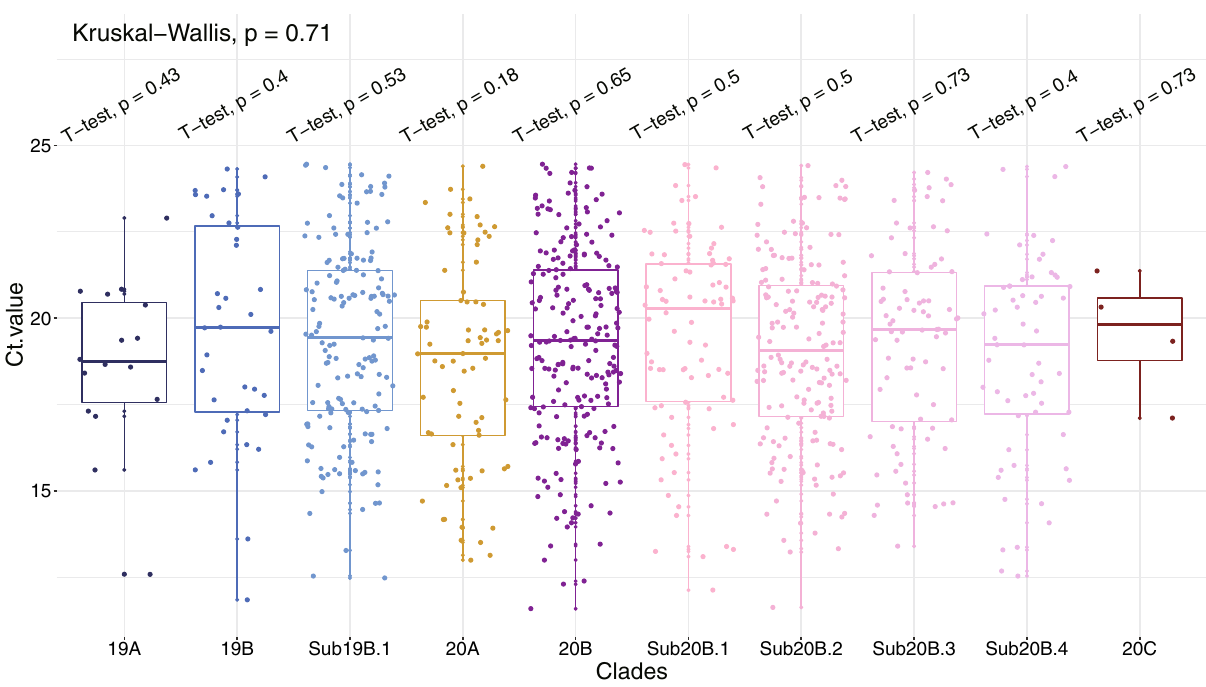
Figure 3. Functional analysis of the unique variants and subclade in the UAE samples. RT-qPCR Ct value distribution for samples in each of the five dominant clades and five subclades. Shown is the p-value using Kruskai–Wallis test and p-value by performing T-test comparing the Ct value for patients carrying certain clade or subclade virus strains with the rest of the patients who did not carry the virus belong to a specific clade or